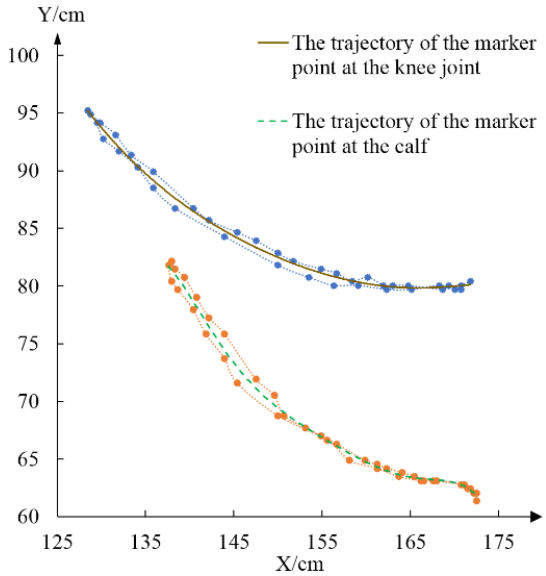
Figure 8. The trajectories of two marker points.